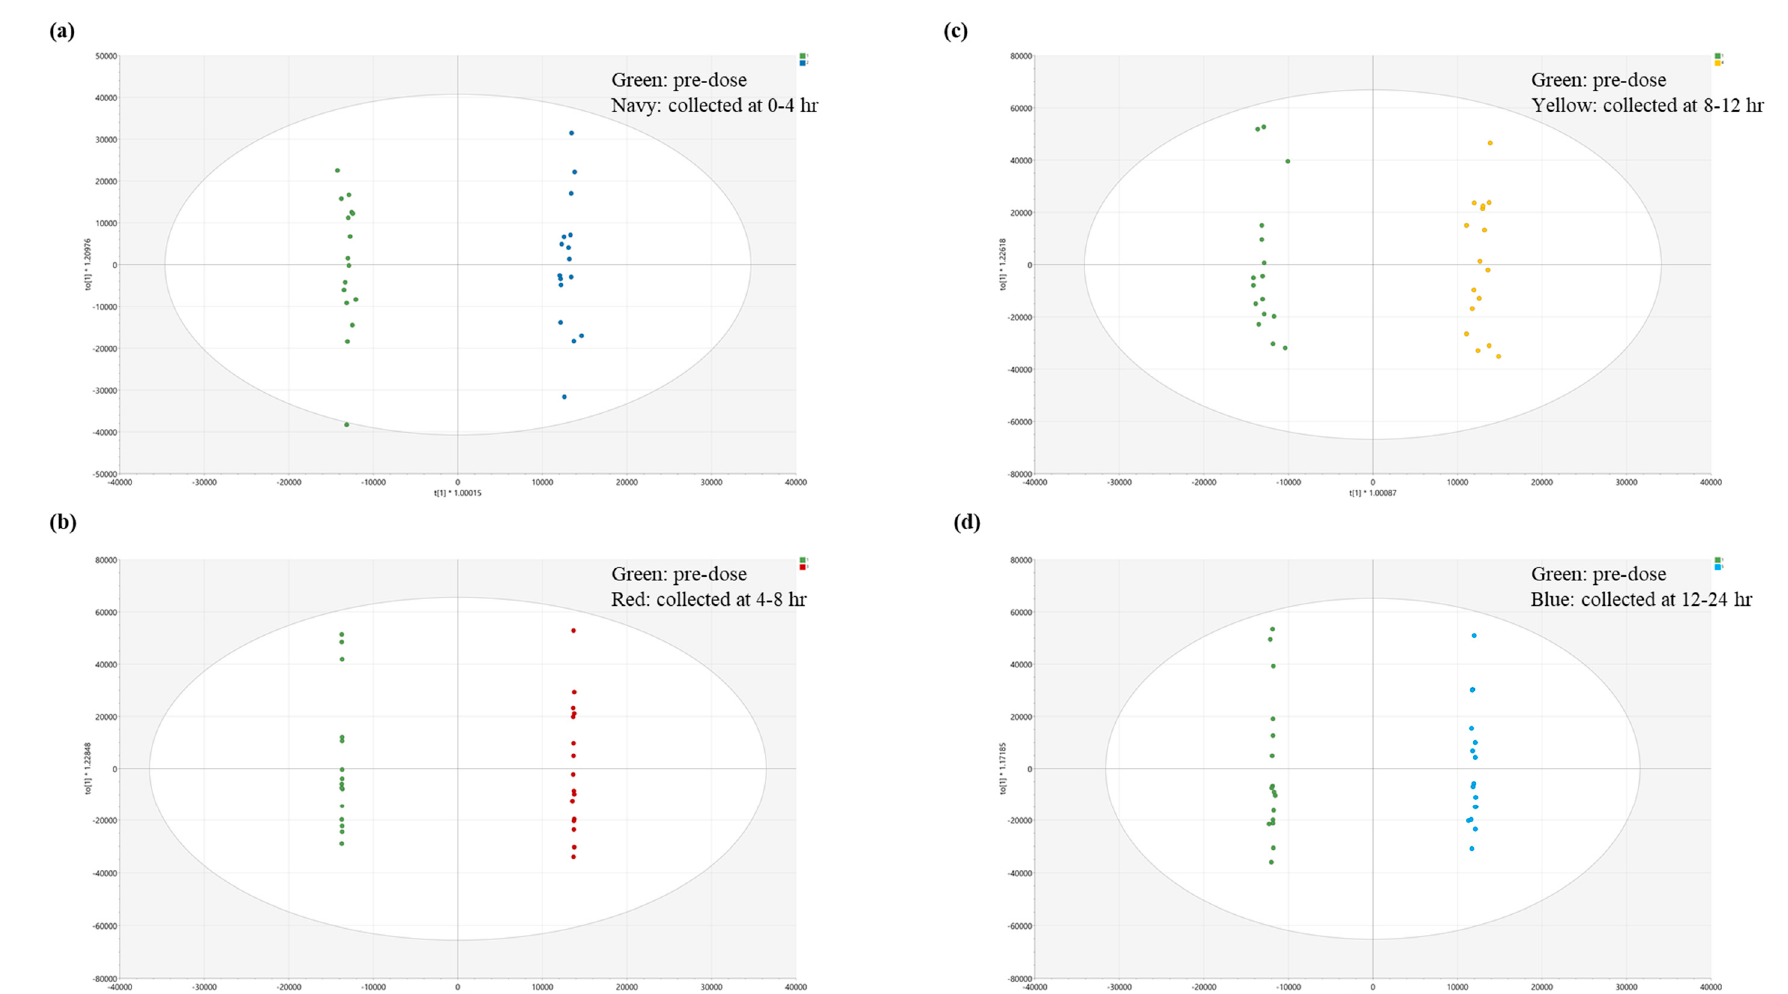
Figure 2. The scatter plots of orthogonal partial least squares discriminant analysis (OPLS-DA) of pre-dose and postdosing urine samples after 90 mg single dosing after fasting. Each model shows the difference between urine samples of pre-dose and ( a ) 0–4 h, ( b ) 4–8 h, ( c ) 8–12 h, and ( d ) 12–24 h after administration.